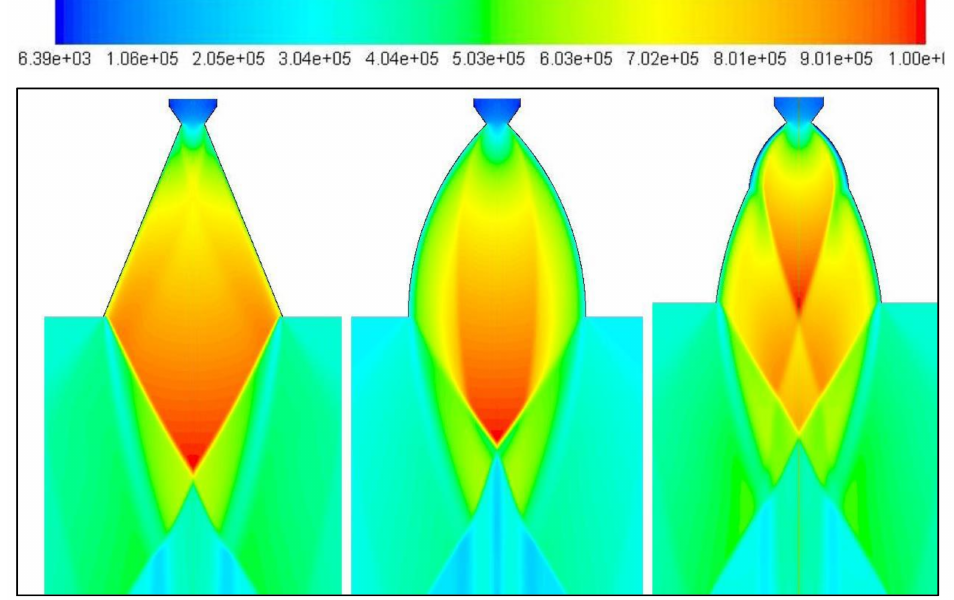
Figure 26. Pressure contours for conical, bell nozzle, and dual bell ozzle at 10,000 ft and Mach 1.5.